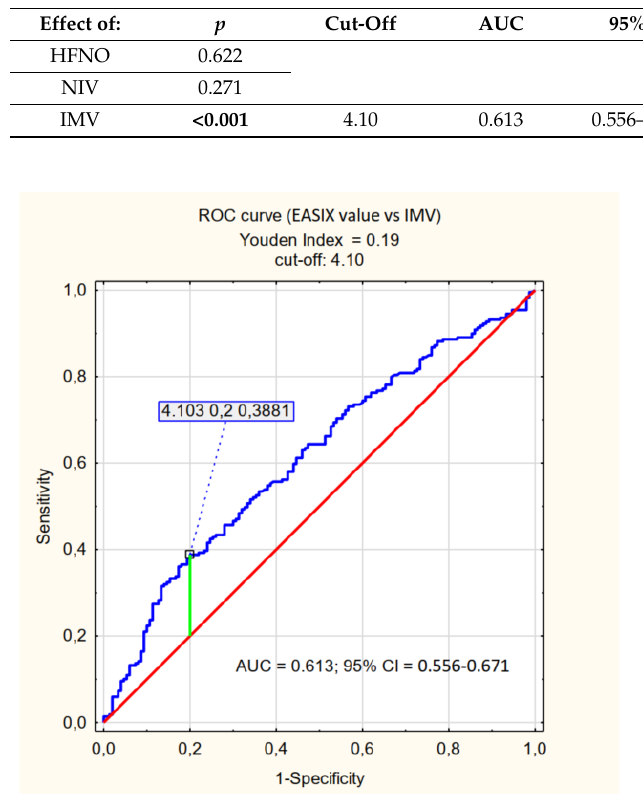
Table 4. Correlation of EASIX values (cut-off, AUC, sensitivity, specificity) with regard to the need to apply particular methods of oxygen therapy.